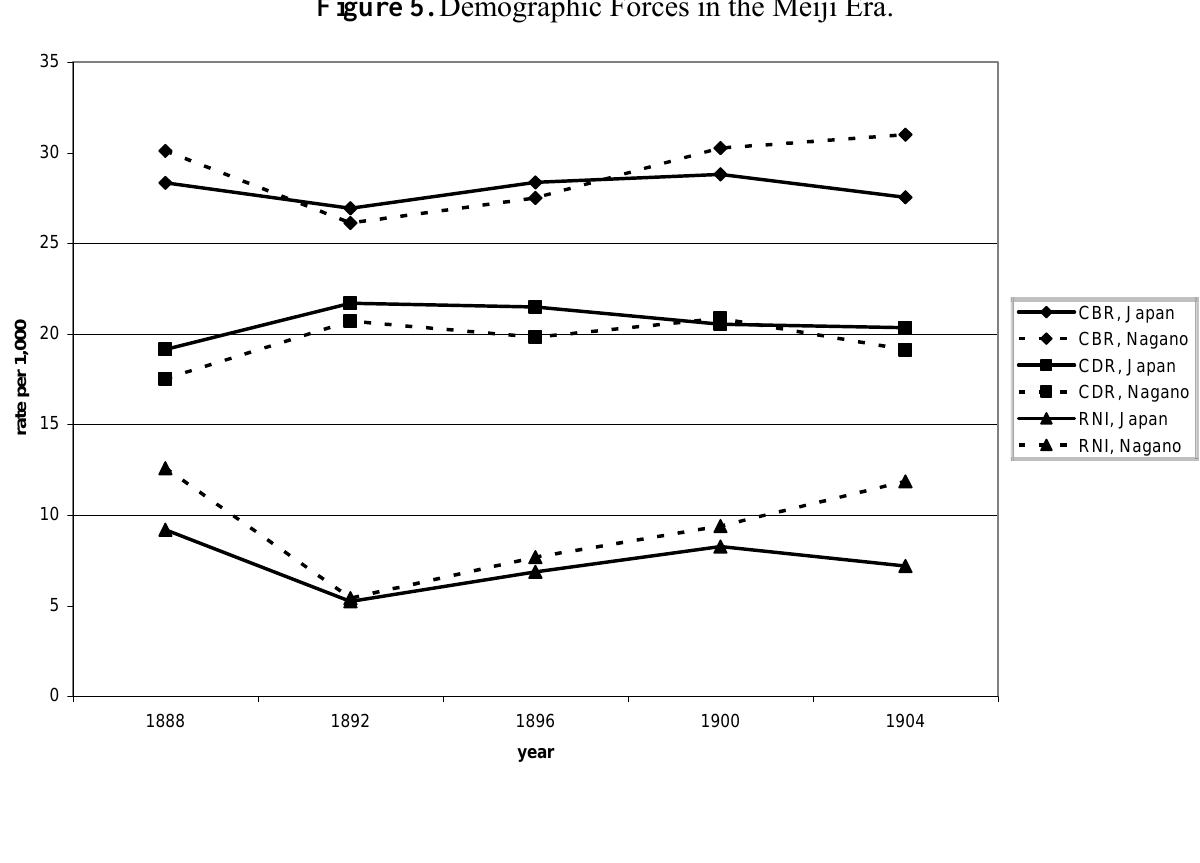
Figure 5. Demographic Forces in the Meiji